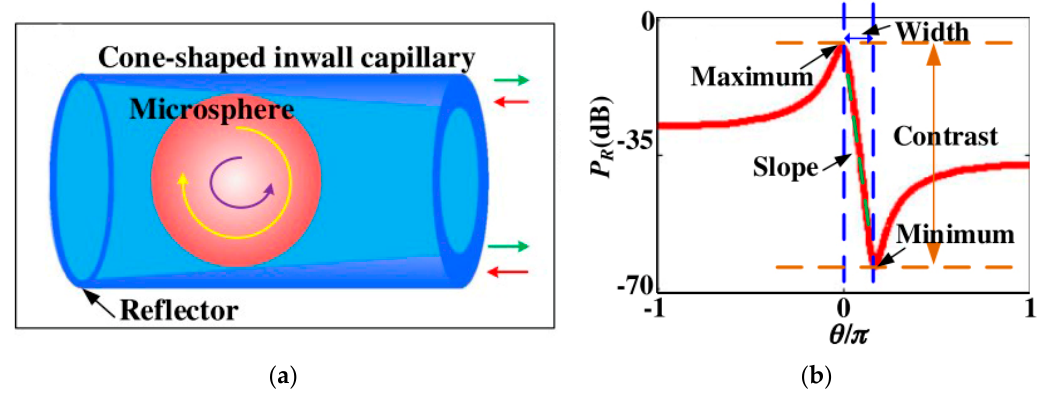
Figure 12. ( a ) The experimental schematic of the Fano resonator; ( b ) relationship between the Fano resonant output power and normalized frequency. [Reprinted/Adapted] with permission from ref [39], [OSA].